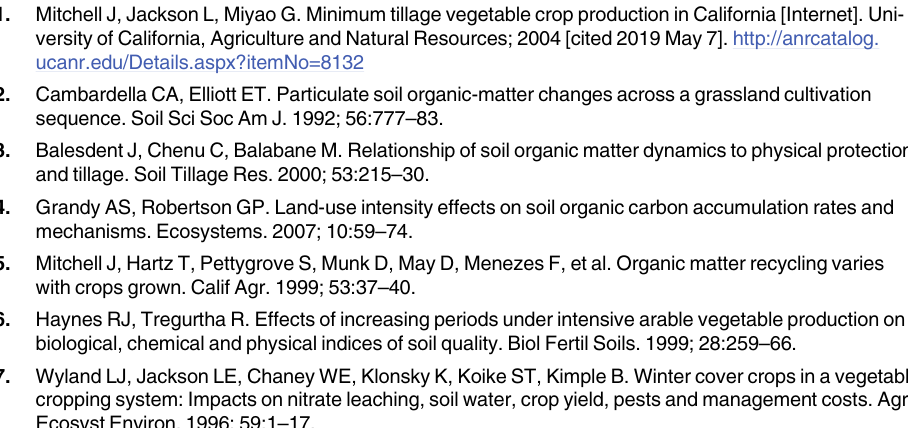
ha -1 before each vegetable crop), cover crop type (legume-rye, mustard, or cereal rye alone) and cover cropping frequency (quadrennially vs. annually planted). Error bars are 95% confi- dence limits. Individual data points for reps 1 through 4 of each system are clustered in order from left to right around the mean, which is represented by the horizontal lines. S3 Fig. Cover crop type effect on soil organic carbon stocks. Soil organic carbon stocks over 8 years in three organic vegetable systems in Salinas, CA that all received annual compost addi- tions (7.6 Mg ha -1 before each vegetable crop) and differed by annually planted cover crop type. (TIF) S1 Table. Summary statistics (means, 95% confidence limits, and standard errors) for car- bon inputs, soil carbon stocks measured in years 0 through 8 and permanganate oxidizable carbon in years 0, 6 and